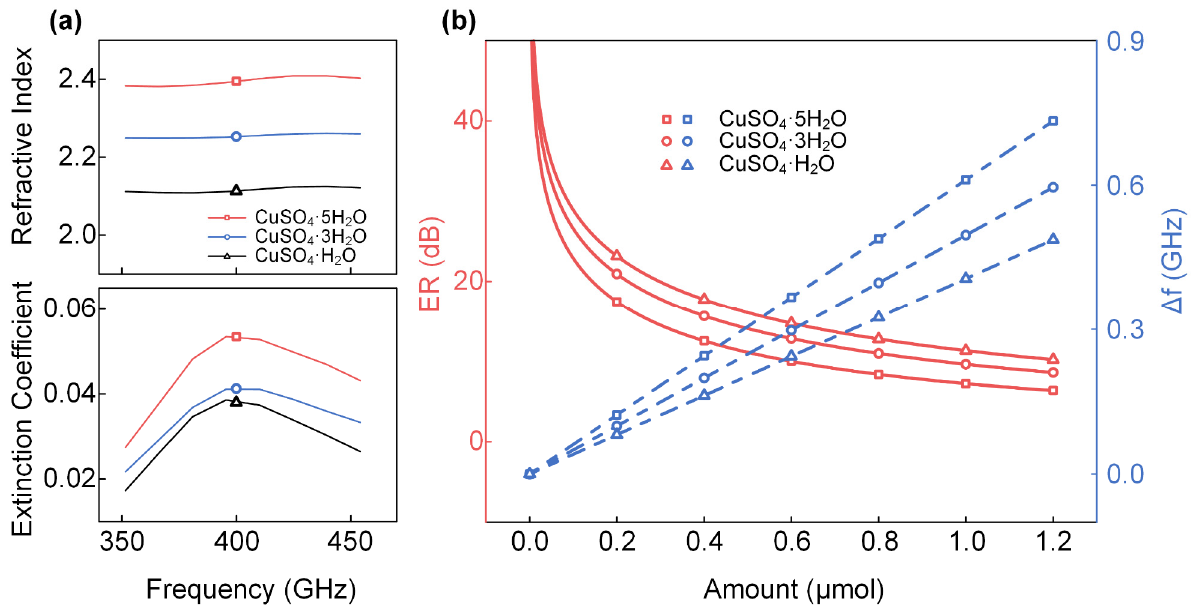
Figure 4. The complex refractive indices of CuSO 4 ·xH 2 O (x = 5, 3, 1) and the simulated sensing results for different amounts of CuSO 4 ·xH 2 O (x = 5, 3, 1). ( a ) Refractive indexes and extinction coefficients of CuSO 4 ·xH 2 O (x = 5, 3, 1) with the frequency from 350 to 450 GHz. ( b ) The ERs (red) and frequency shifts (blue) of the resonance dip.